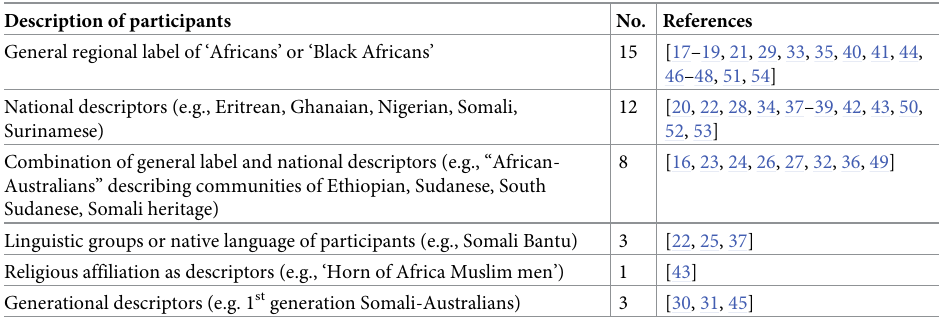
Table 2. Description of